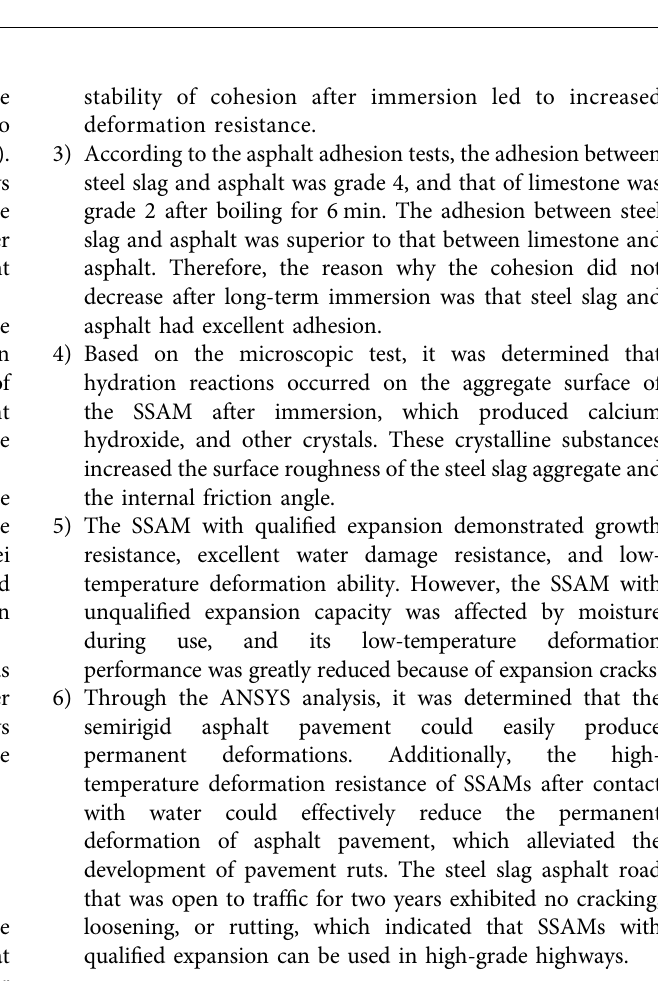
Frontiers in Materials |